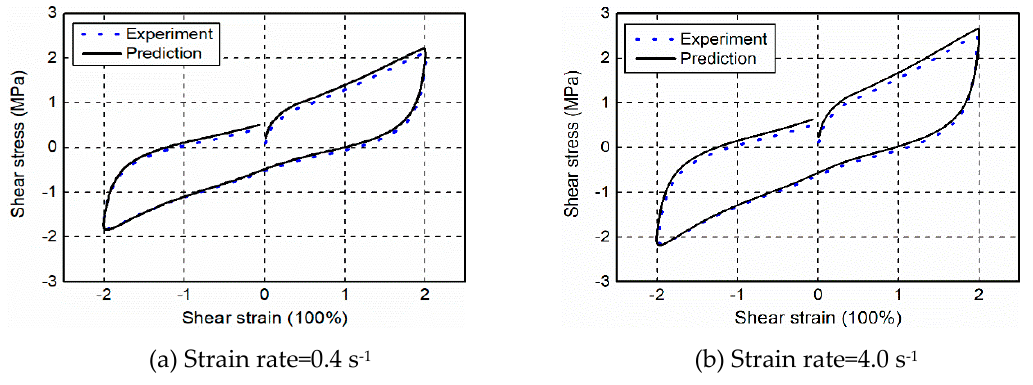
Figure 13. Comparison of cyclic shear tests and model predictions.